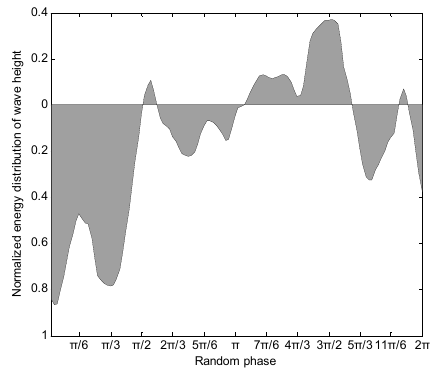
Figure 8. Correlation difference distribution of Fractal method.